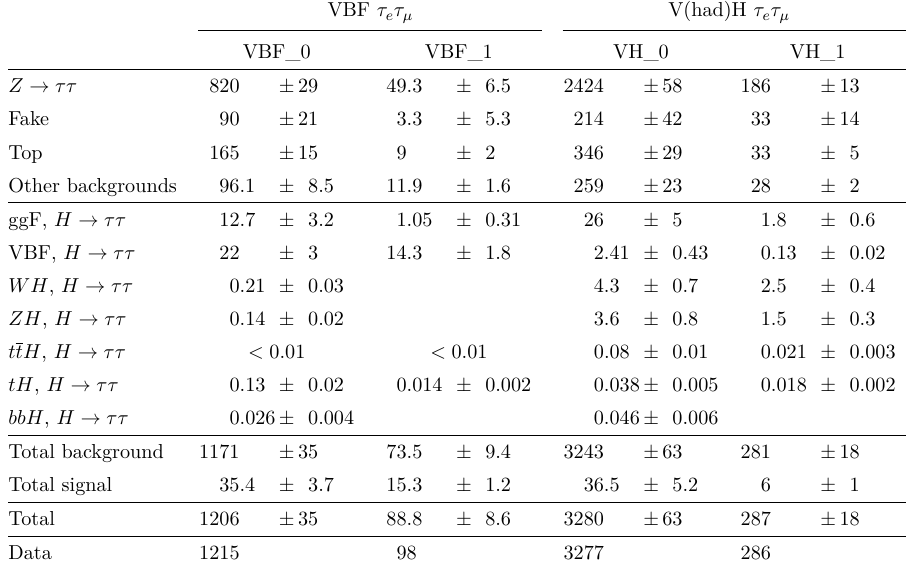
Table 10. Observed event yields and predictions as computed by the fit in the VBF and V(had)H signal regions of the τ τ channel. Uncertainties include statistical and systematic components. e µ The prediction for each sample is determined from the likelihood fit performed to measure the pp → H → ττ cross-section.